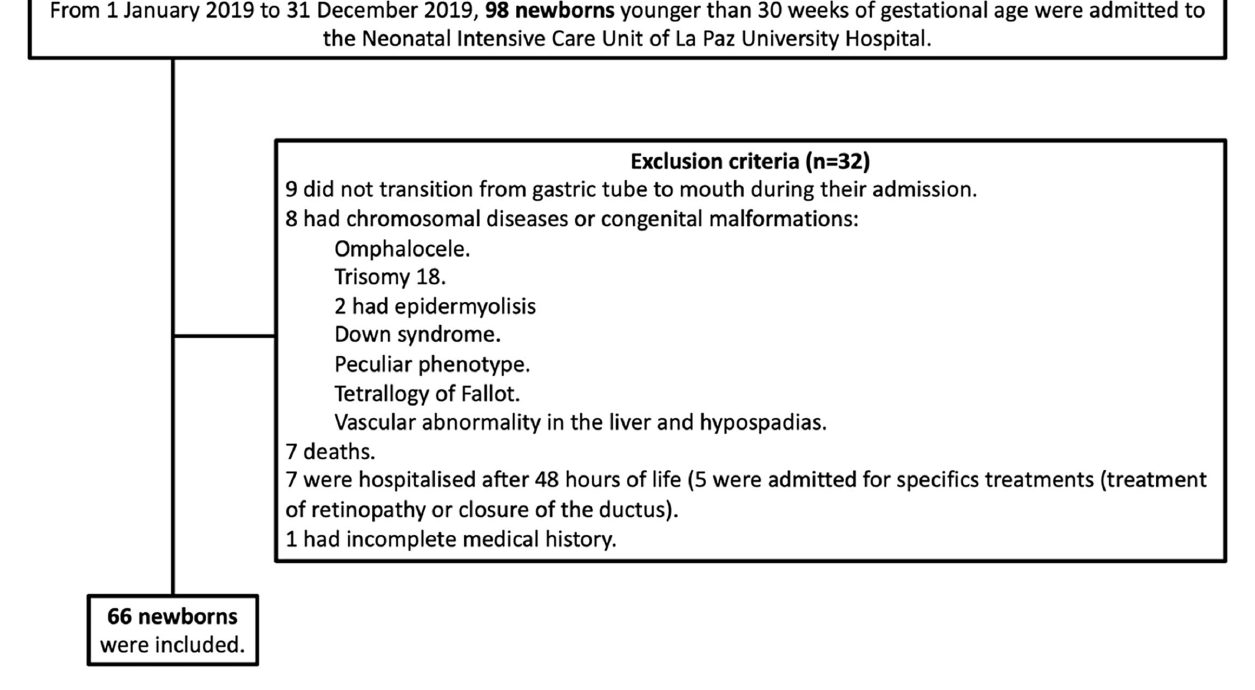
FIGURE 1 | Flowchart of included and excluded